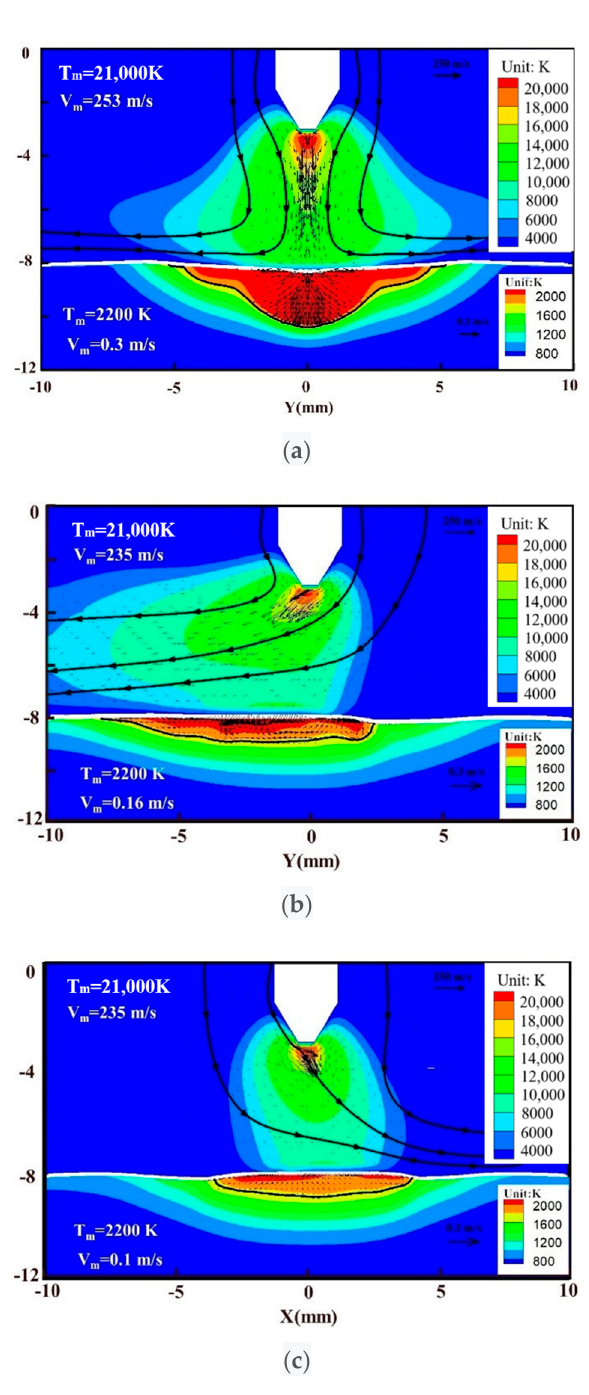
Figure 11. Temperature and flow field distributions: ( a ) I e = 0 ( yoz plane), ( b ) I e = 3 A ( yoz plane), and ( c ) I e = 3 A ( xoz plane).